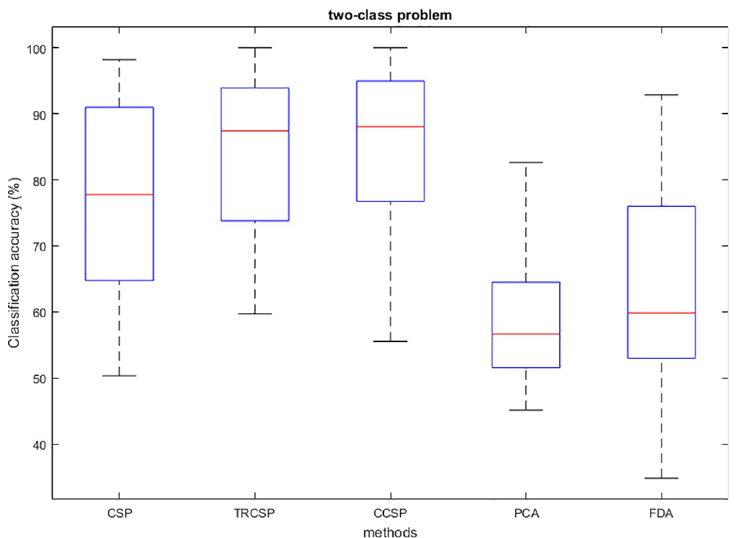
Fig 7. Boxplot of all subject for CSP, TRCSP and CCSP in two-class problem.